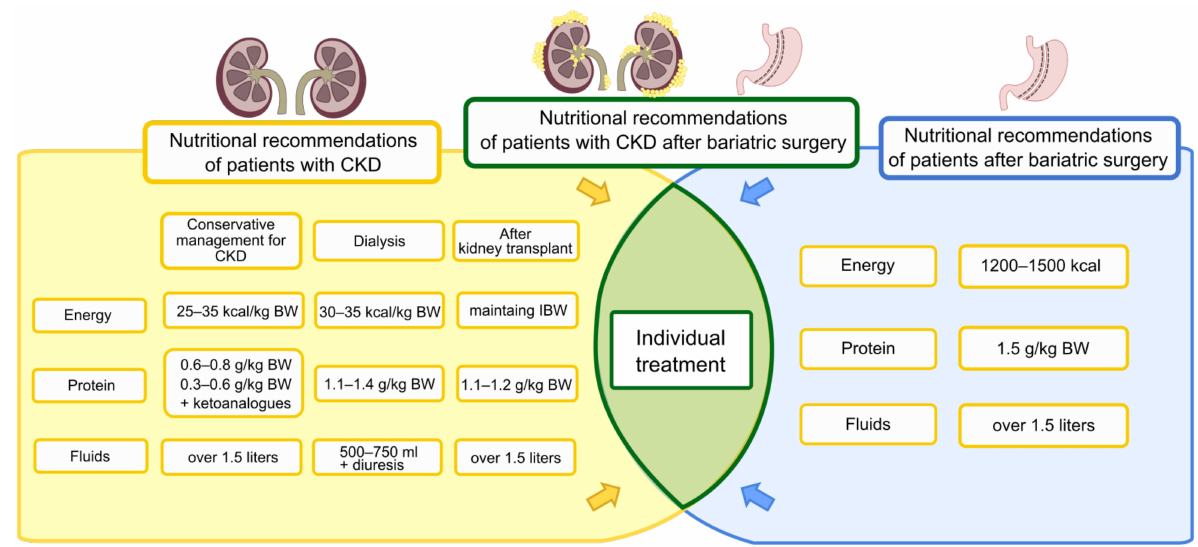
Figure 1. Nutritional recommendations of patients with CKD and after